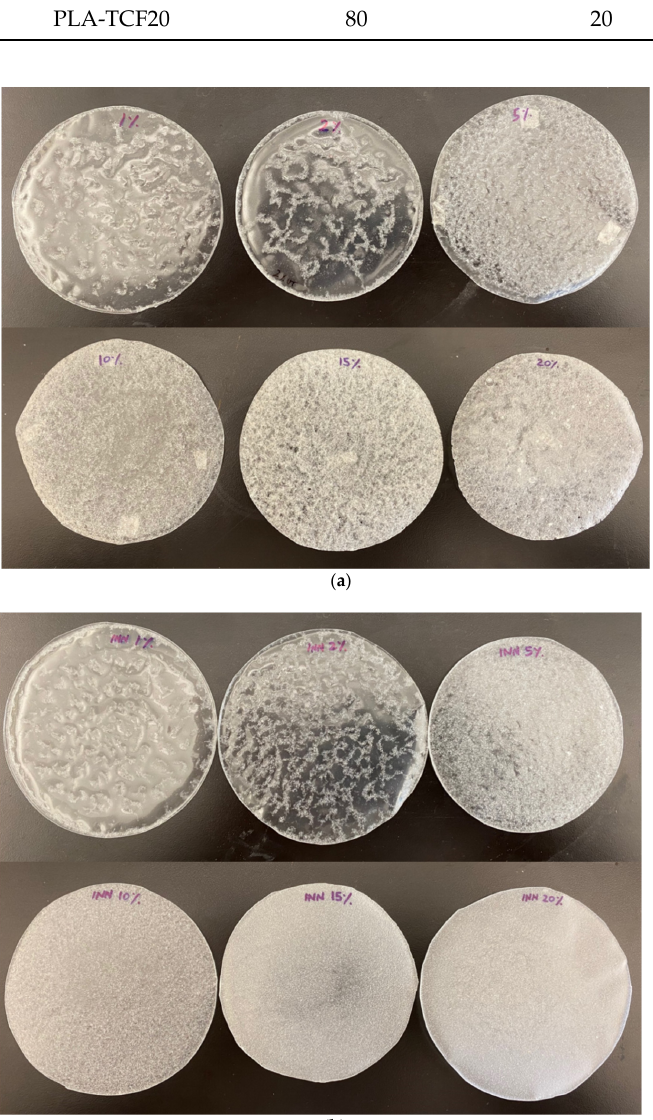
Figure 2. Photographs of ( a ) PLA-UCF films with 1–20% UCF content; ( b ) PLA-TCF films with 1– 20% TCF